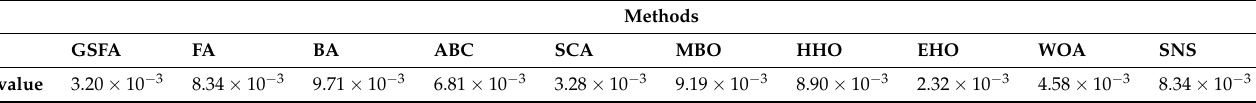
Table 18. Shapiro–Wilk test results for multiple problem analysis.